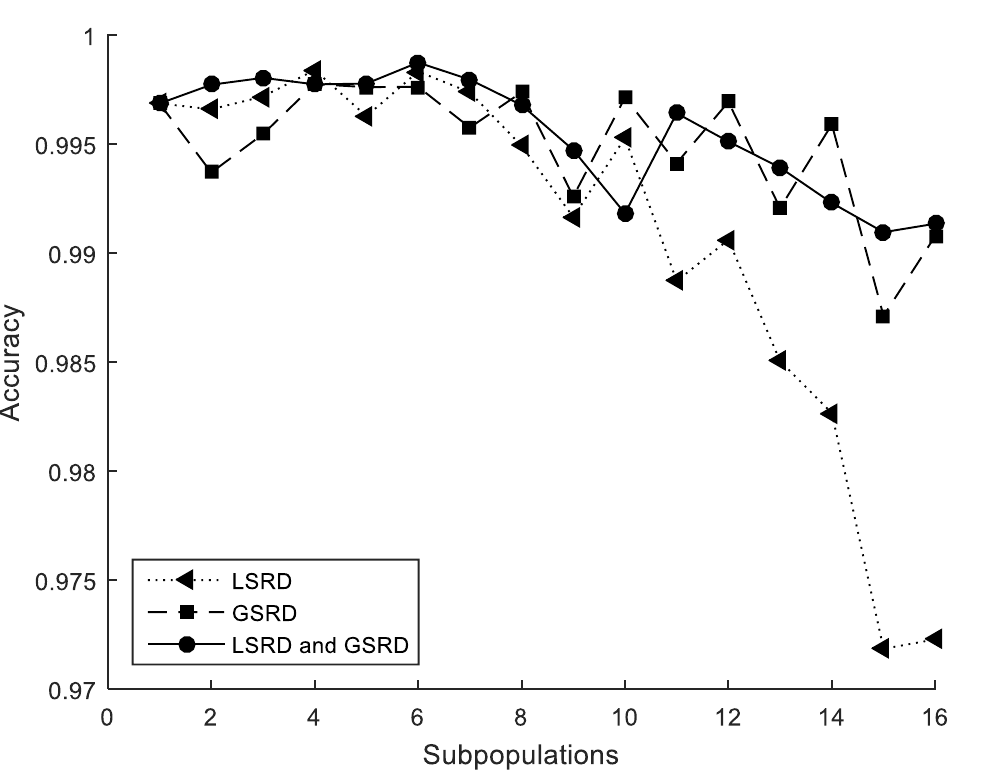
Figure 7. Cross-section under flexure. Accuracy.